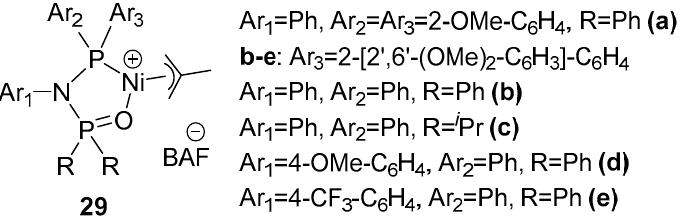
Figure 25. Nickel catalysts 28a – e based on phosphine phosphonic amide ligands.